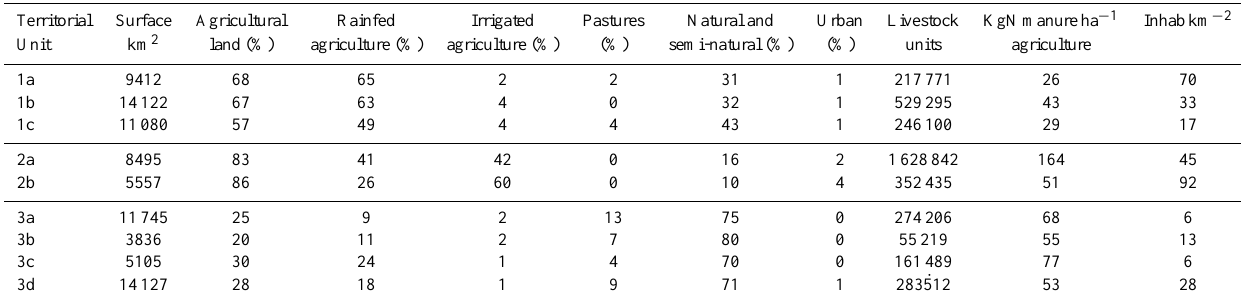
Table 1. Characteristics of the nine territorial